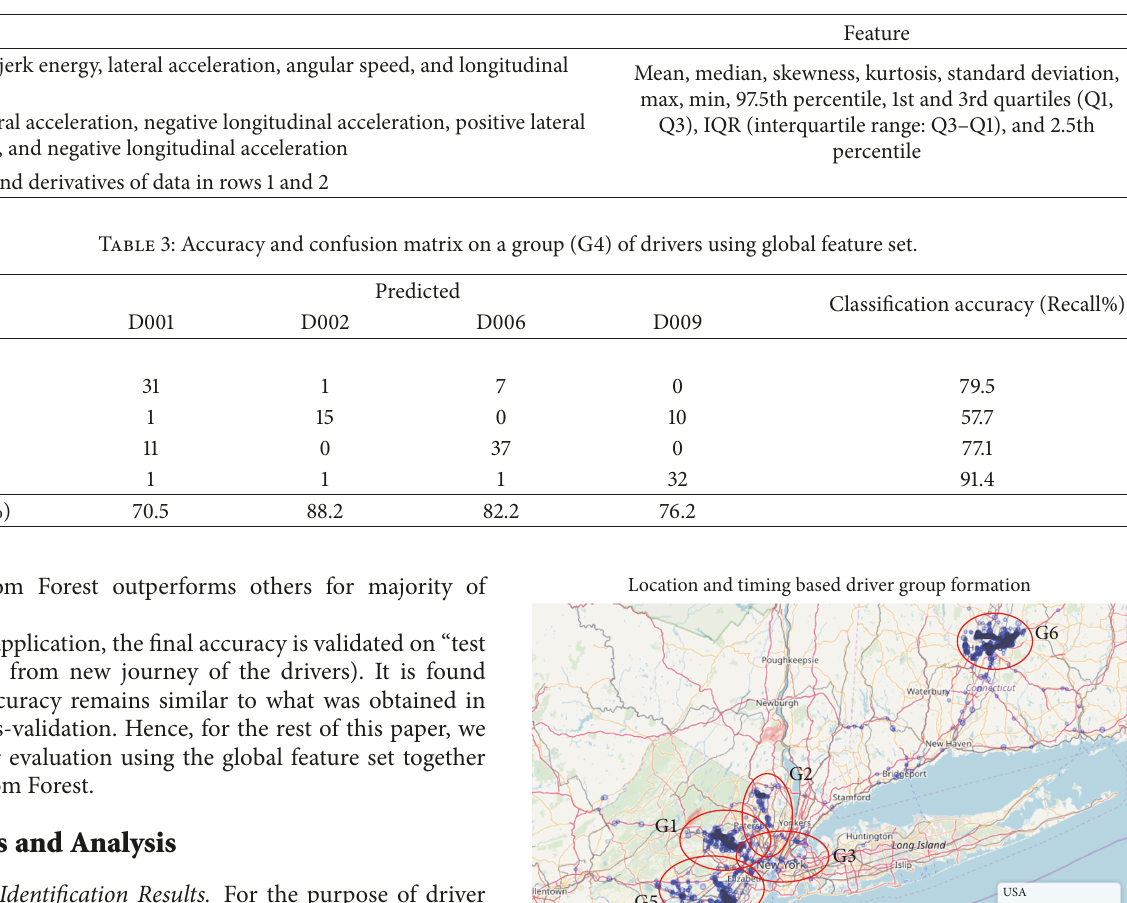
Table 2: Summary of features for driver identification.